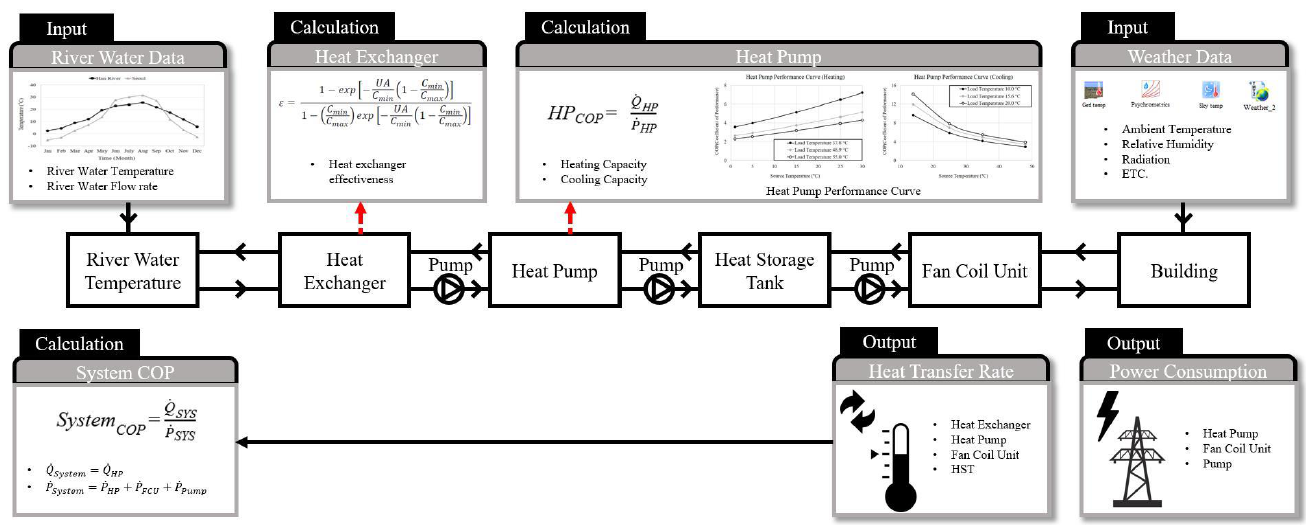
Figure 6. Schematic of the simulation. Table 3. Specifications of simulation components.